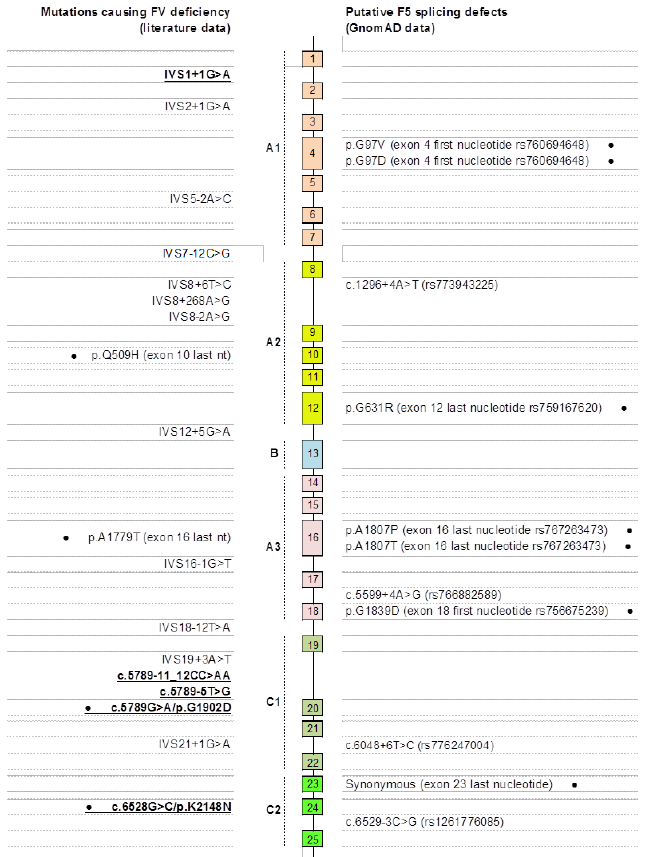
Figure 3. Mutational spectrum of FV deficiency. ( a ) The pie chart shows the distribution of the different types of mutations identified in the F5 gene. Data were retrieved from the Human Gene Mutation Database (HGMD) database (public version) with some minor amendments: (i) two of the listed splicing defects are erroneously reported by the HGMD, and were not included in the figure; (ii) the missense mutation reported by Bafunno et al. [24] has been counted among the splicing defects. The chart also includes the four mutations identified in this work. ( b ) The mutational spectrum of the F5 gene exclusively refers to the splicing defects. All of the known causative mutations for FV deficiency are projected on the exon–intron structure of F5 on the left side of the scheme (data retrieved from the literature), whereas the putative splicing defects extracted from the GnomAD database are reported on the right (with the RefSeq indication, if available). Exons are represented by boxes; introns are represented by lines (not to scale). The FV domain structure is also indicated. Missense mutations affecting the first/last nucleotide of the exon are indicated by a black dot beside the name; the mutations functionally characterized in this work are bolded and